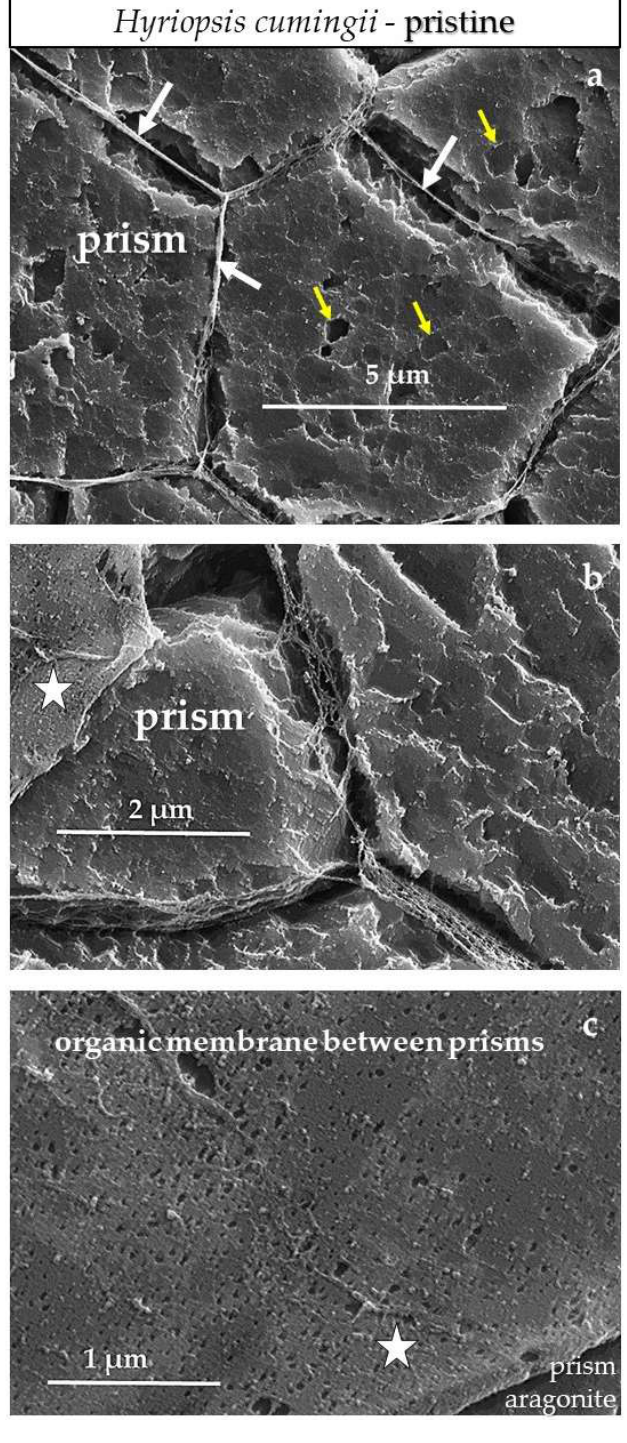
Figure A17. FE-SEM images of etched sample surfaces showing in top view; ( a , b ) the assemblage of prisms with occluded biopolymer membranes (white arrows in ( a ), white stars in ( b , c ) between them. Well visible is the porous nature of the membranes ( b , c ). Well visible is the internal structuring of prisms (e.g., ( a )). Yellow arrows in ( a ) point to roundish mineral grains that are slightly misoriented to each other.